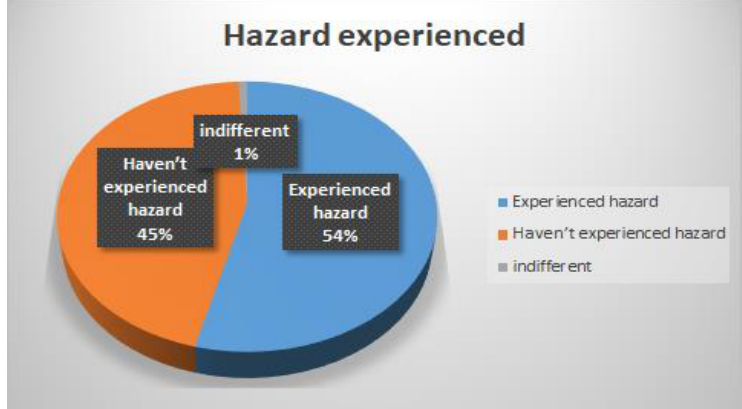
Figure 2. Hazards experienced during waste picking. Source: Computed by authors.